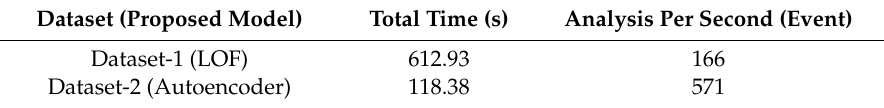
Table 9. Performance measurement results of the proposed model.